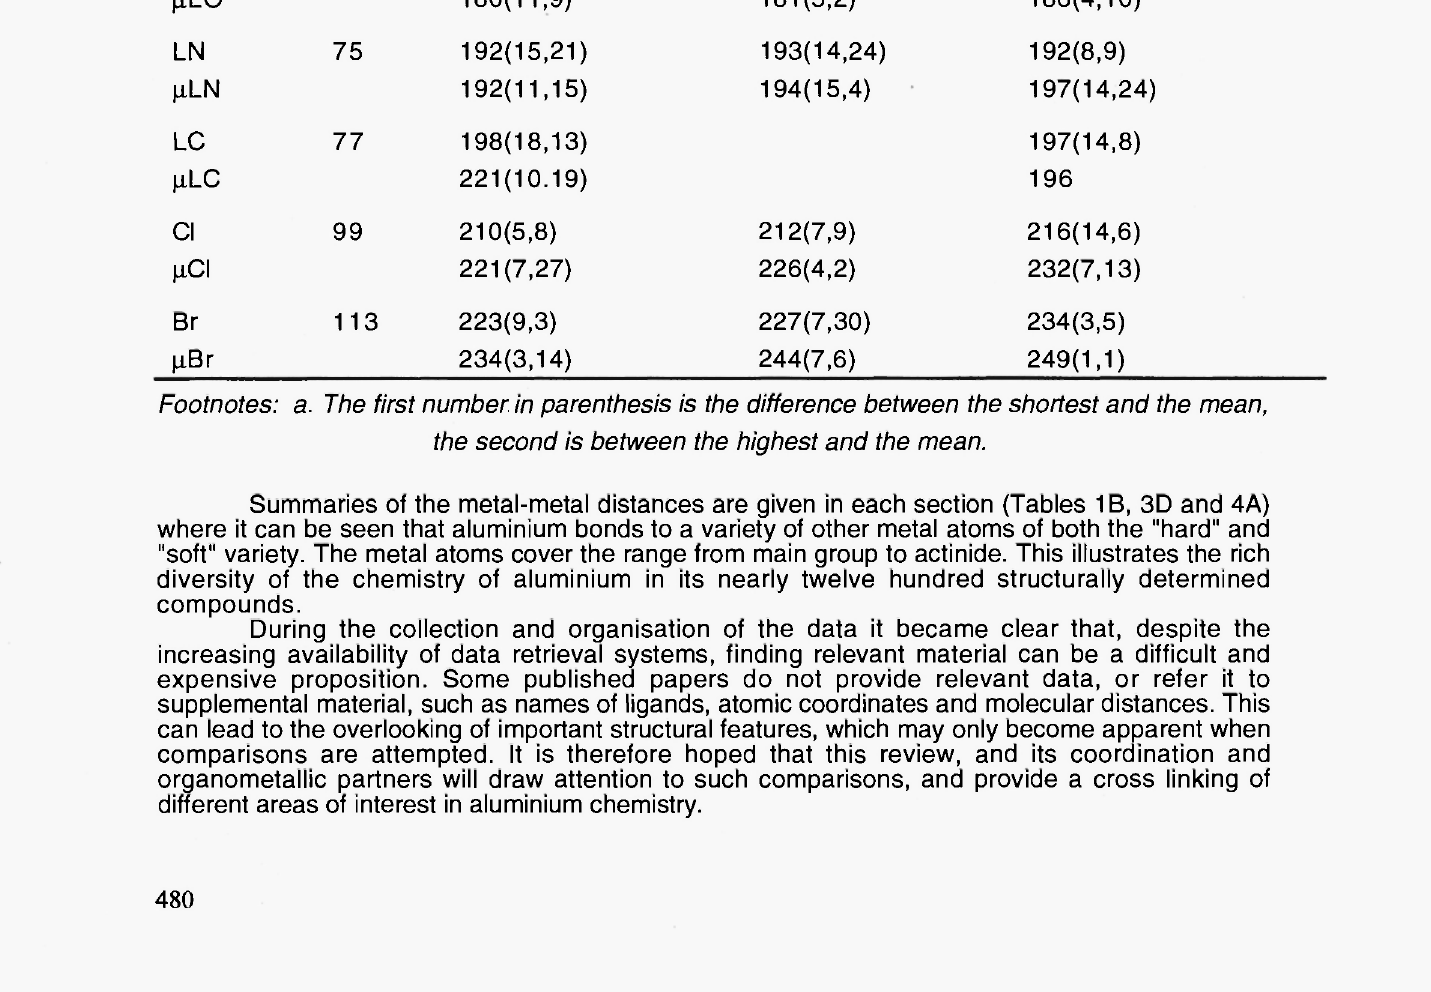
6. Summary of the Mean g Al"'-L(atom) Bond Distances (pm) for Four Coordinate